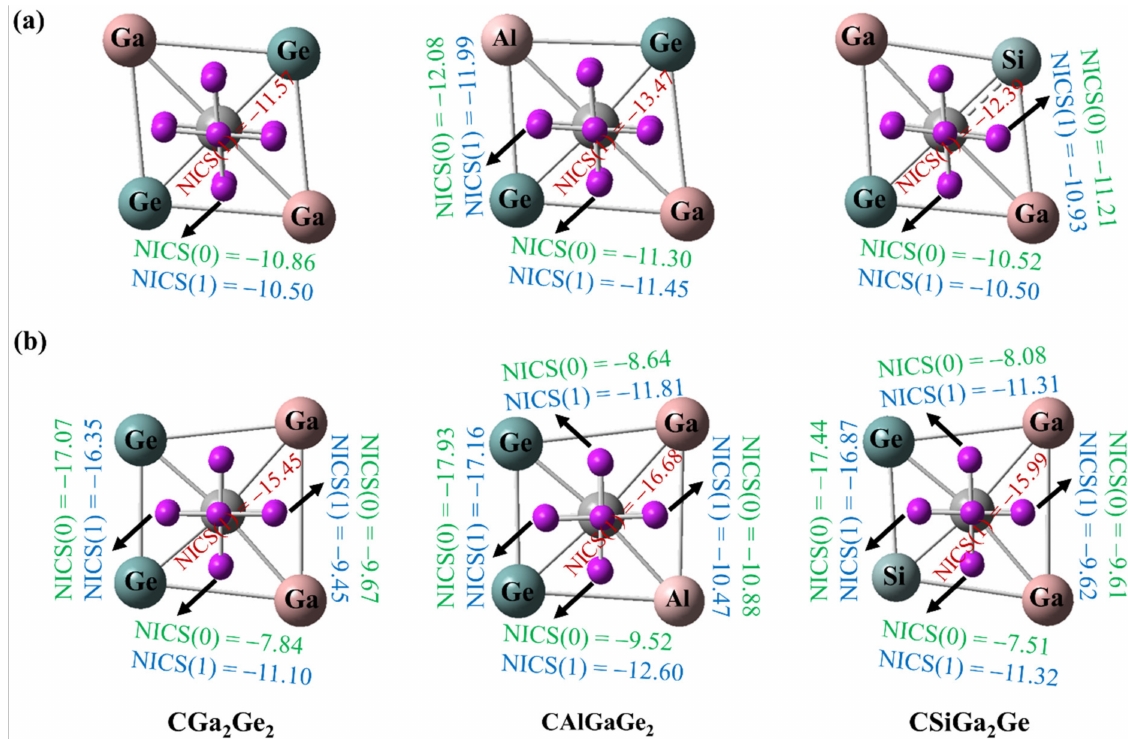
Figure 10. Nucleus independent chemical shifts (NICSs; in ppm) for ( a ) trans geometries; ( b ) cis geometries. The values in the red color indicate the NICS (1) values at 1 Å above the central C atom of the